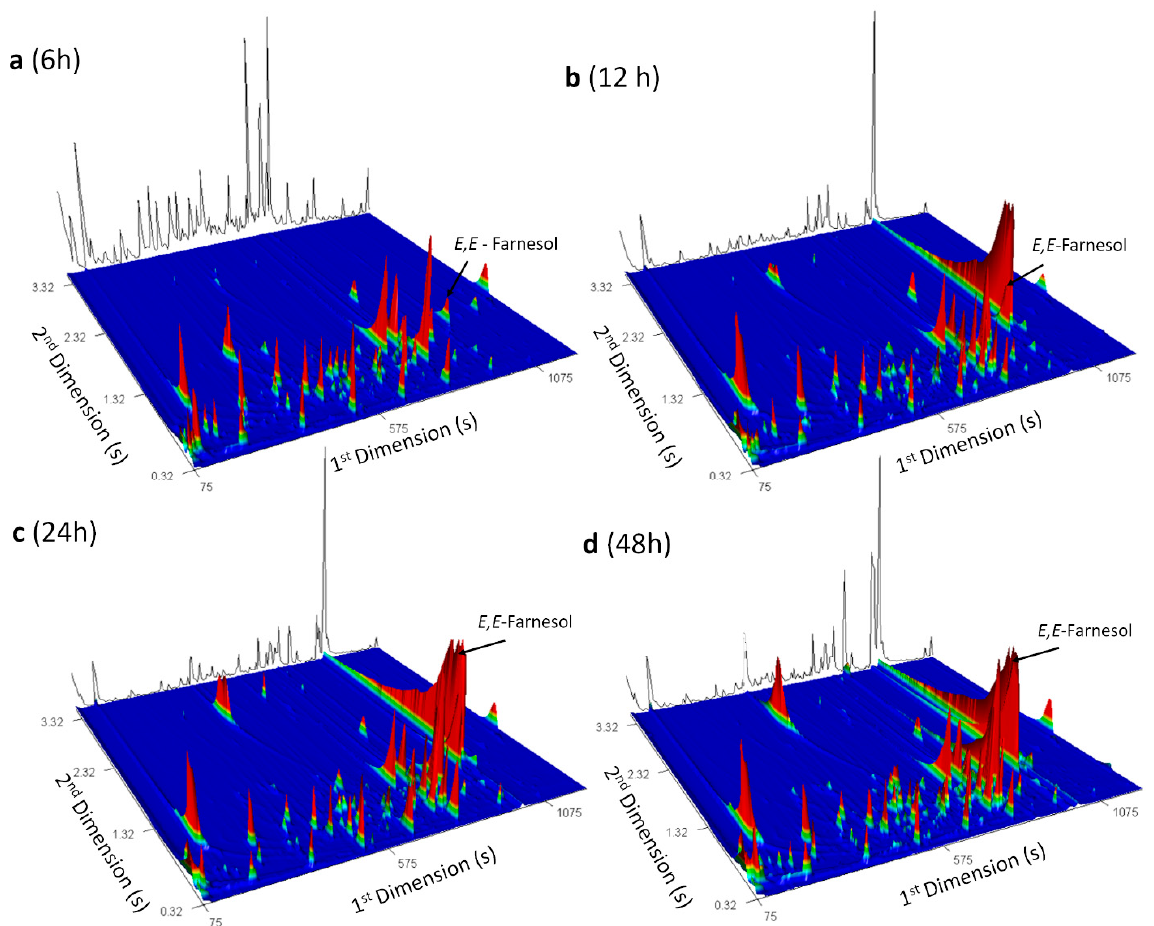
Figure 3. Selected GC × GC–ToFMS total ion chromatogram contour plot of the C. albicans cultures headspace volatile compounds at four growth times: ( a ) 6 h, ( b ) 12 h, ( c ) 24 h and ( d ) 48 h of culture headspace volatile compounds, used to illustrate a yeast metabolomic profile. E,E- Farnesol, an important quorum-sensing molecule, was highlighted.